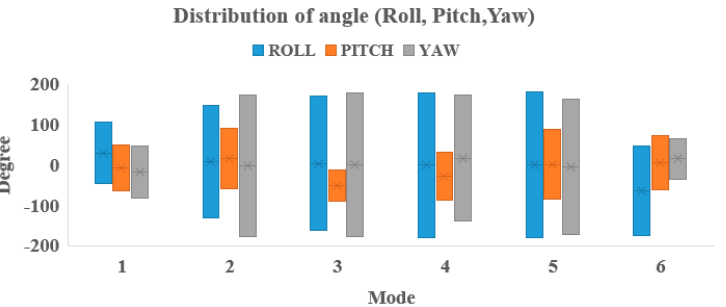
Figure 3. Three complex modes with groups of muscles in dumbbell train.